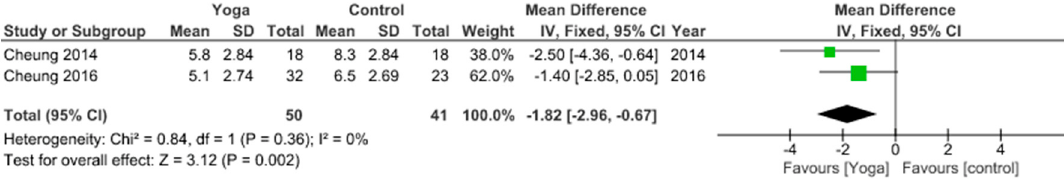
Figure 6. Pain: Yoga versus Control.